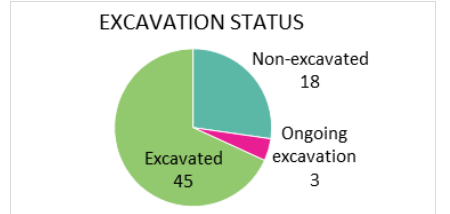
Figure 1. Distribution of sites according to excavation status